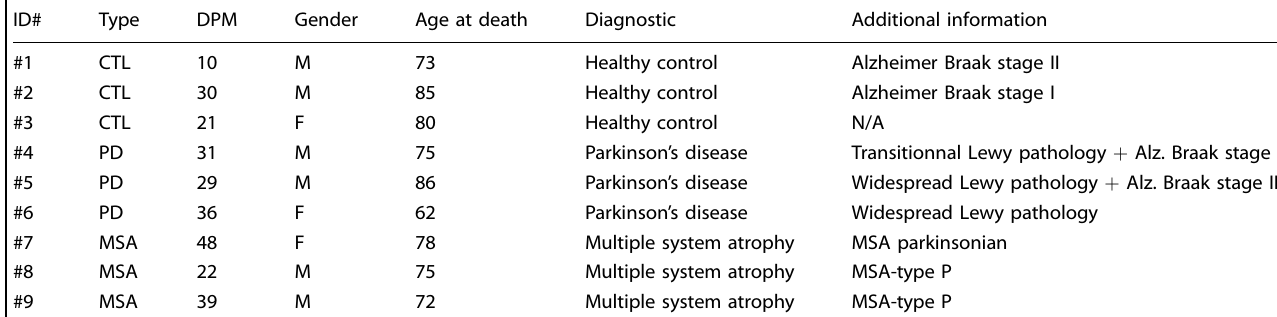
Table 1. Human subject anonymized